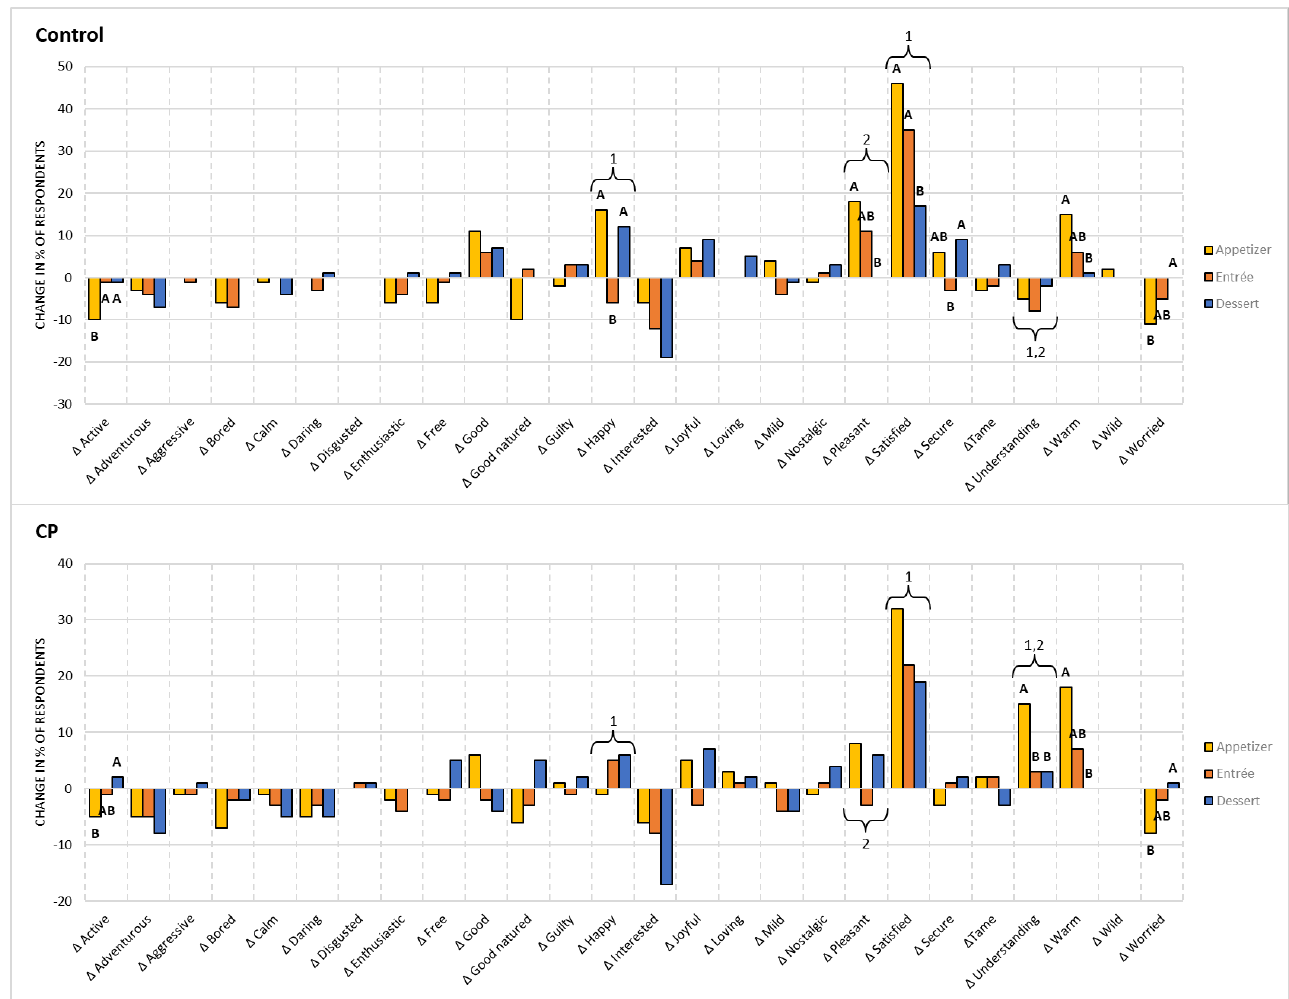
Figure 3. ΔEmotion for each emotion term before and after evaluating a dish for both the Control and CP versions. Emotions terms denoted by a number (shown on both versions) were found to have a significant difference ( p < 0.05) in the change in emotion term selection between the Control and CP, with (1) being the Appetizer and (2) the Entrée, using a two-way ANOVA blocked on Treatment (Control and CP) and Participant. No differences were found for the change in emotion selection between the Control and CP ( p > 0.05). Control and/or CP dishes with differentiating letters, for each emotion term, were found to be significantly different ( p < 0.05) using a two-way ANOVA, blocked on Product (sausage, pasta, and brownie) and Participant, followed by Tukey’s means comparisons test.